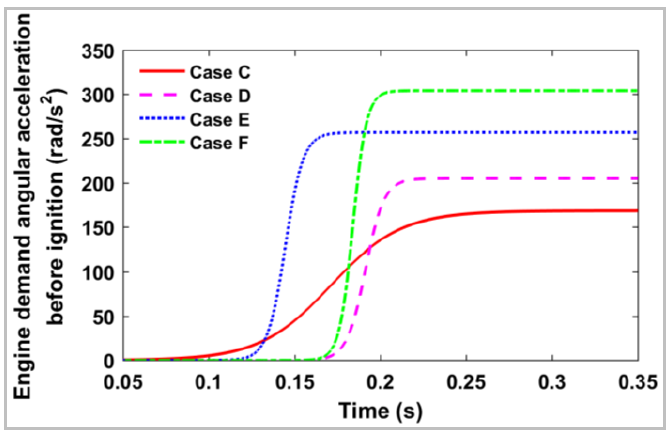
12 Figure 22. Optimized engine demand-angular acceleration before ignition. Figure 22. Optimized engine demand-angular acceleration before ignition.